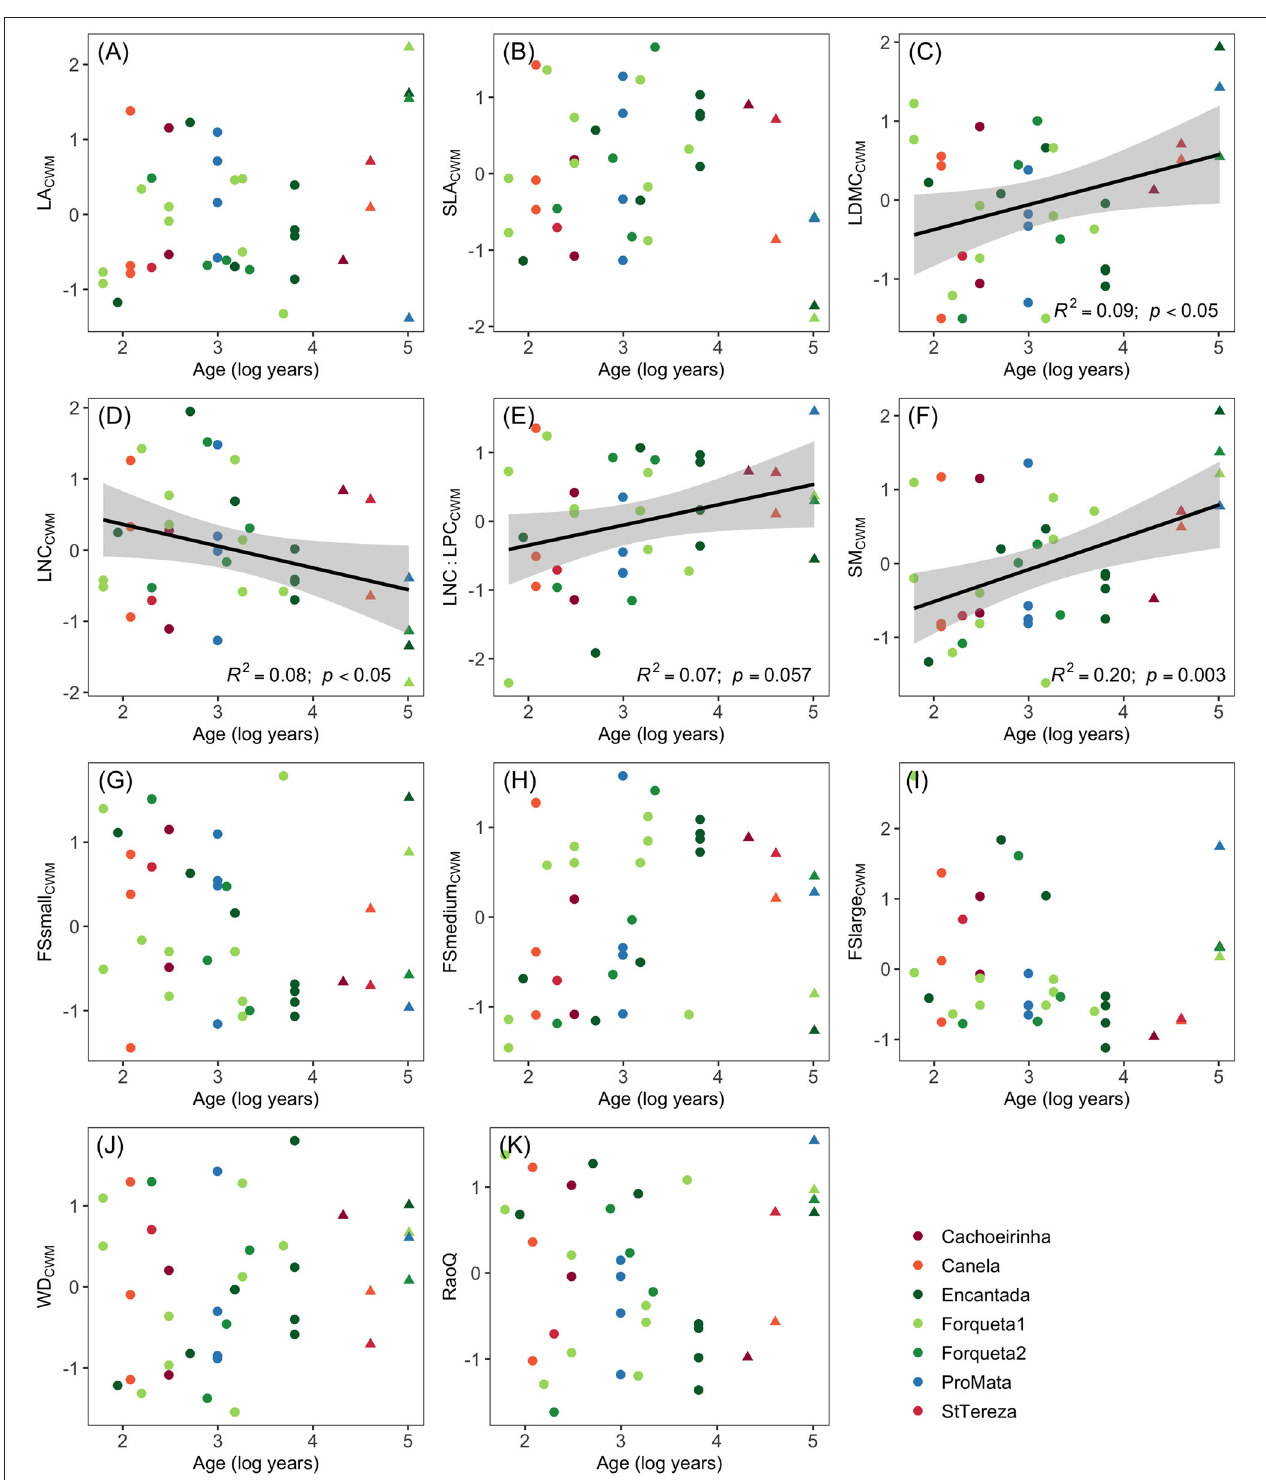
FIGURE 1 | Scatter diagrams of functional trait composition (CWM: community-weighted means; A-J ) and diversity (RaoQ: based on all traits; K ) from the tree regeneration component of secondary forests of southern Brazilian Atlantic Forest against the age since regeneration started. Successional secondary forest sites are Encantada, Forqueta1, Forqueta2, and ProMata (green-blue colors), while restoration sites are Cachoeirinha, Canela, and StTereza (warm colors). Values for the tree stratum of reference forests are also given and correspond to the oldest forests in the right-hand side of axis x (indicated in triangles). Regression lines indicate significant associations ( p < 0.05 or p = 0.057 for (E) ; see text for further information). LA, leaf area; SLA, specific leaf area; LDMC, leaf dry matter content; LNC, leaf nitrogen content; LNC:LPC, leaf nitrogen-phosphorus ratio; SM, seed mass; FS, fruit size (sm: small; md: medium; lg: large); WD, wood density.